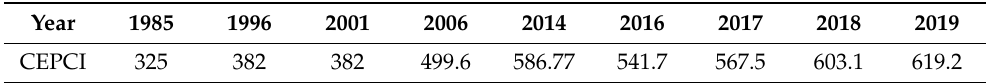
Table 9. CEPCI values